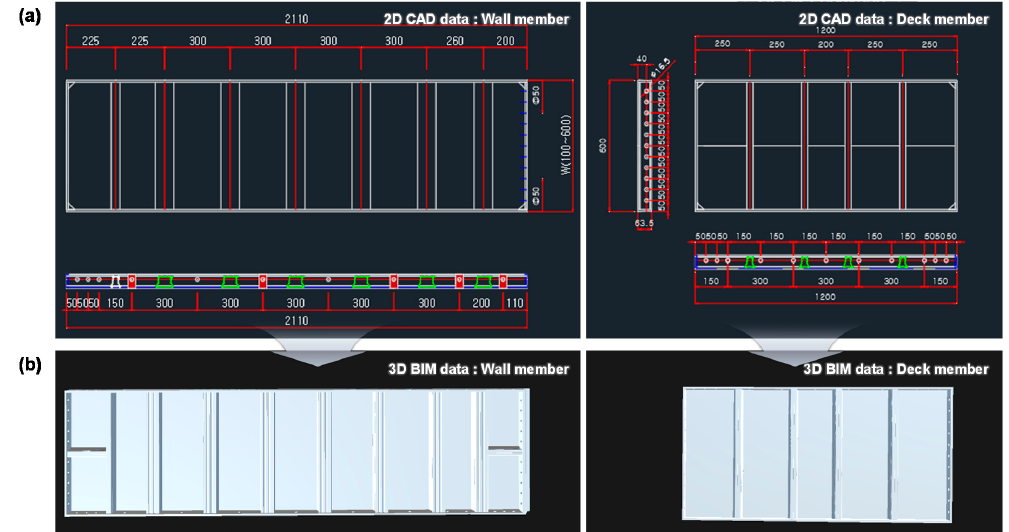
Figure 4. Aluminum formwork library: ( a ) 2D CAD data and ( b ) 3D BIM data.